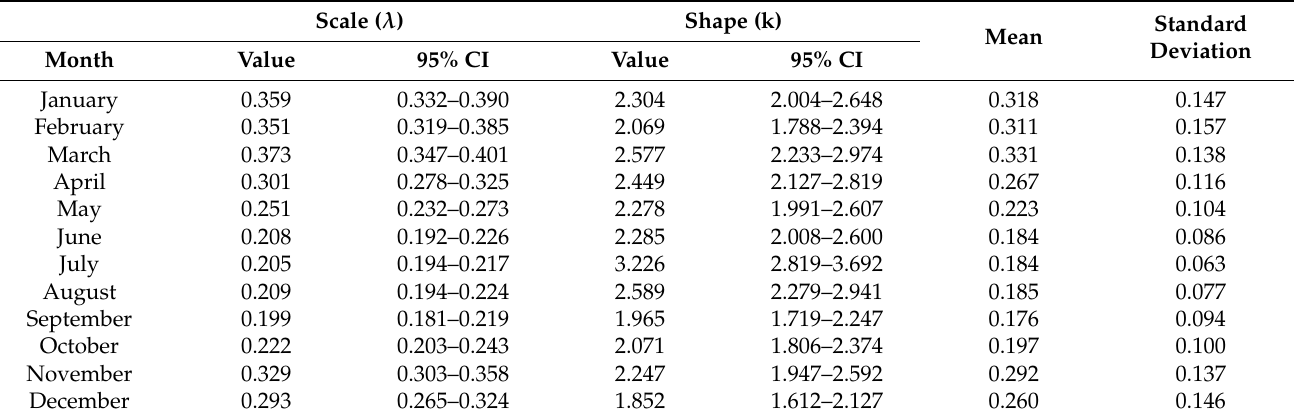
Table 5. Wind power capacity factors: parameters of the Weibull distribution. Scale ( λ